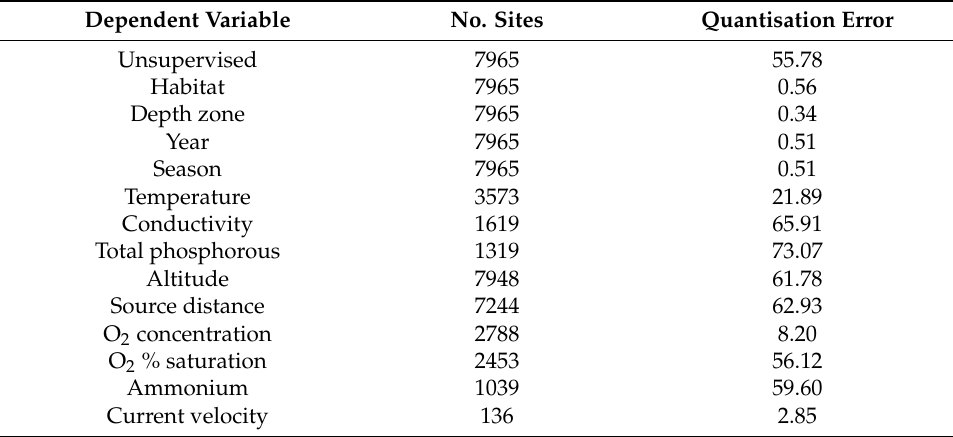
Table 1. Quantization error of the SOM.